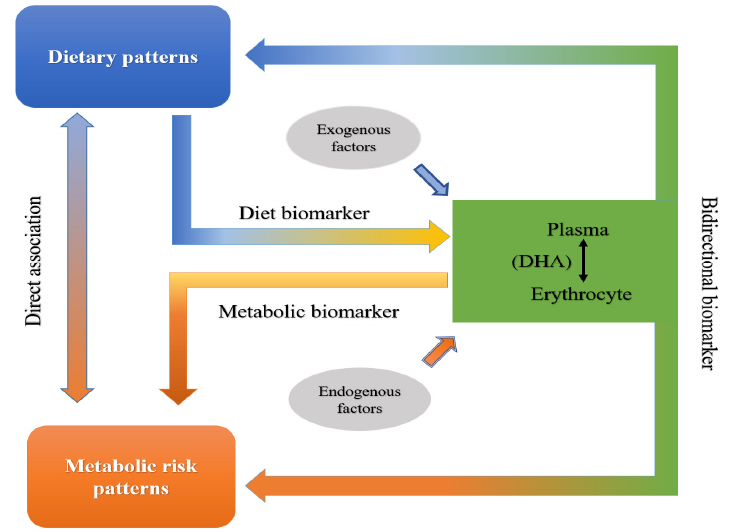
Figure 1. Schematic diagram to precisely identify bidirectional biomarker of blood DHA.